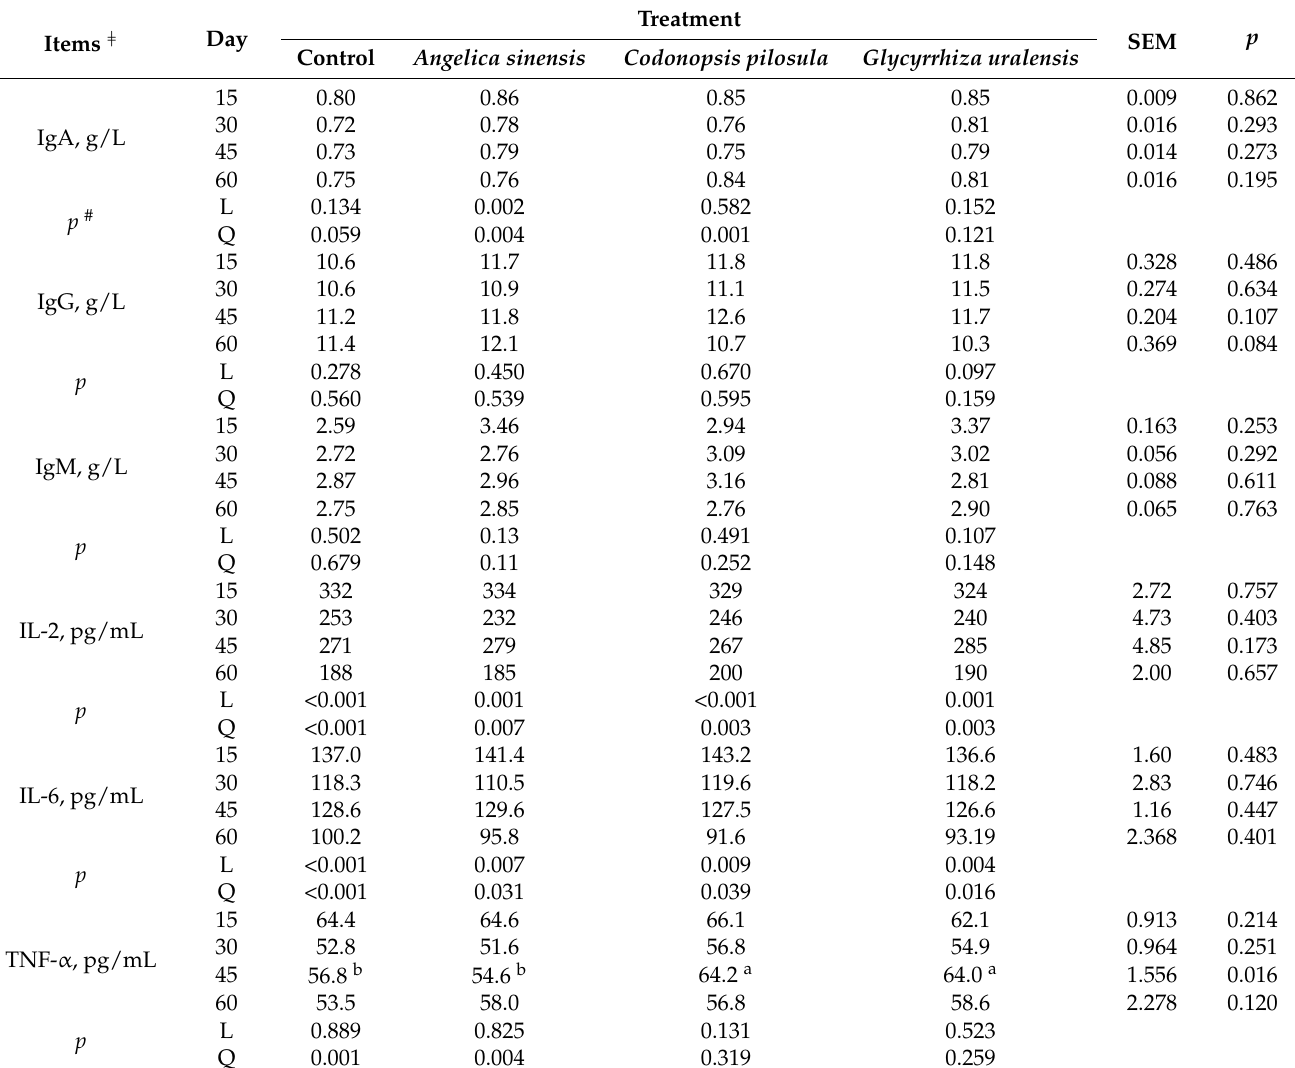
Table 2. Serum immunity indices of early weaned yak calves consuming different herbal extract